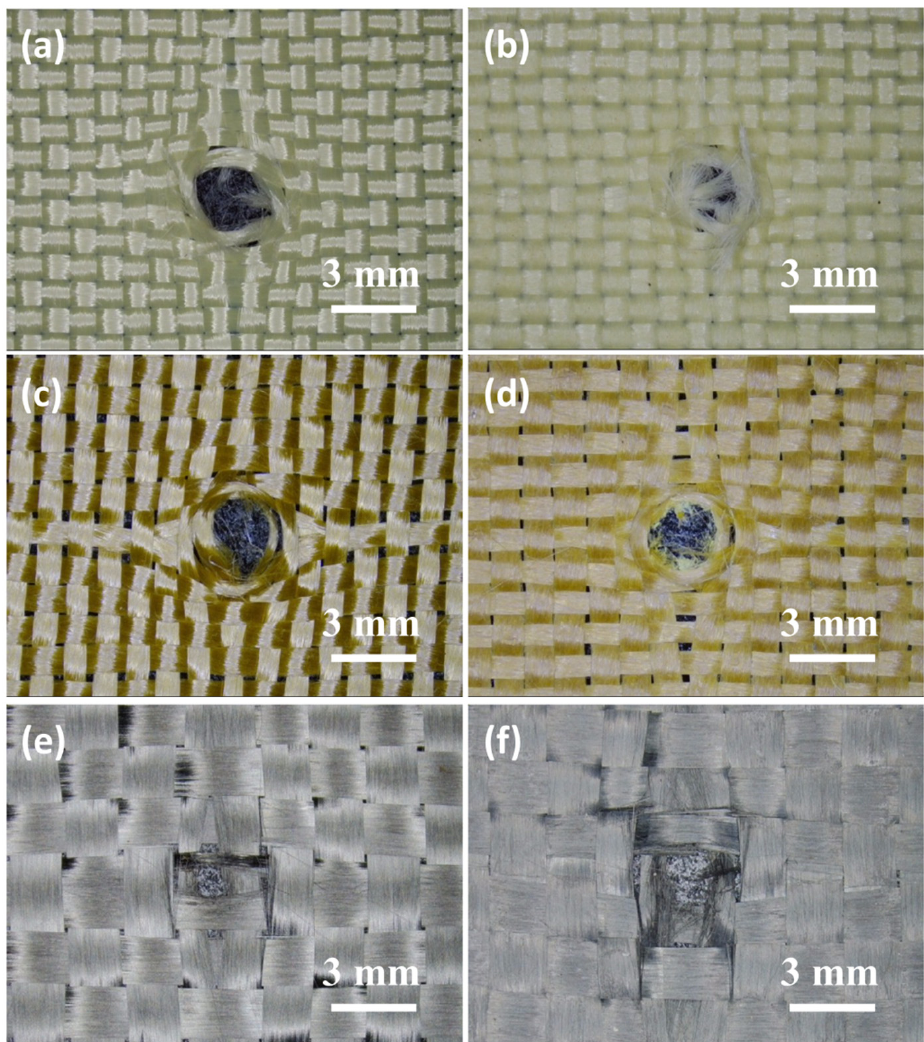
Figure 5. Optical micrographs of the damaged part of ( a ) aramid fabric; ( b ) STF/aramid fabric; ( c ) PBO fabric; ( d ) STF/PBO fabric; ( e ) C fabric; ( f ) STF/C fabric against the D3 tool.